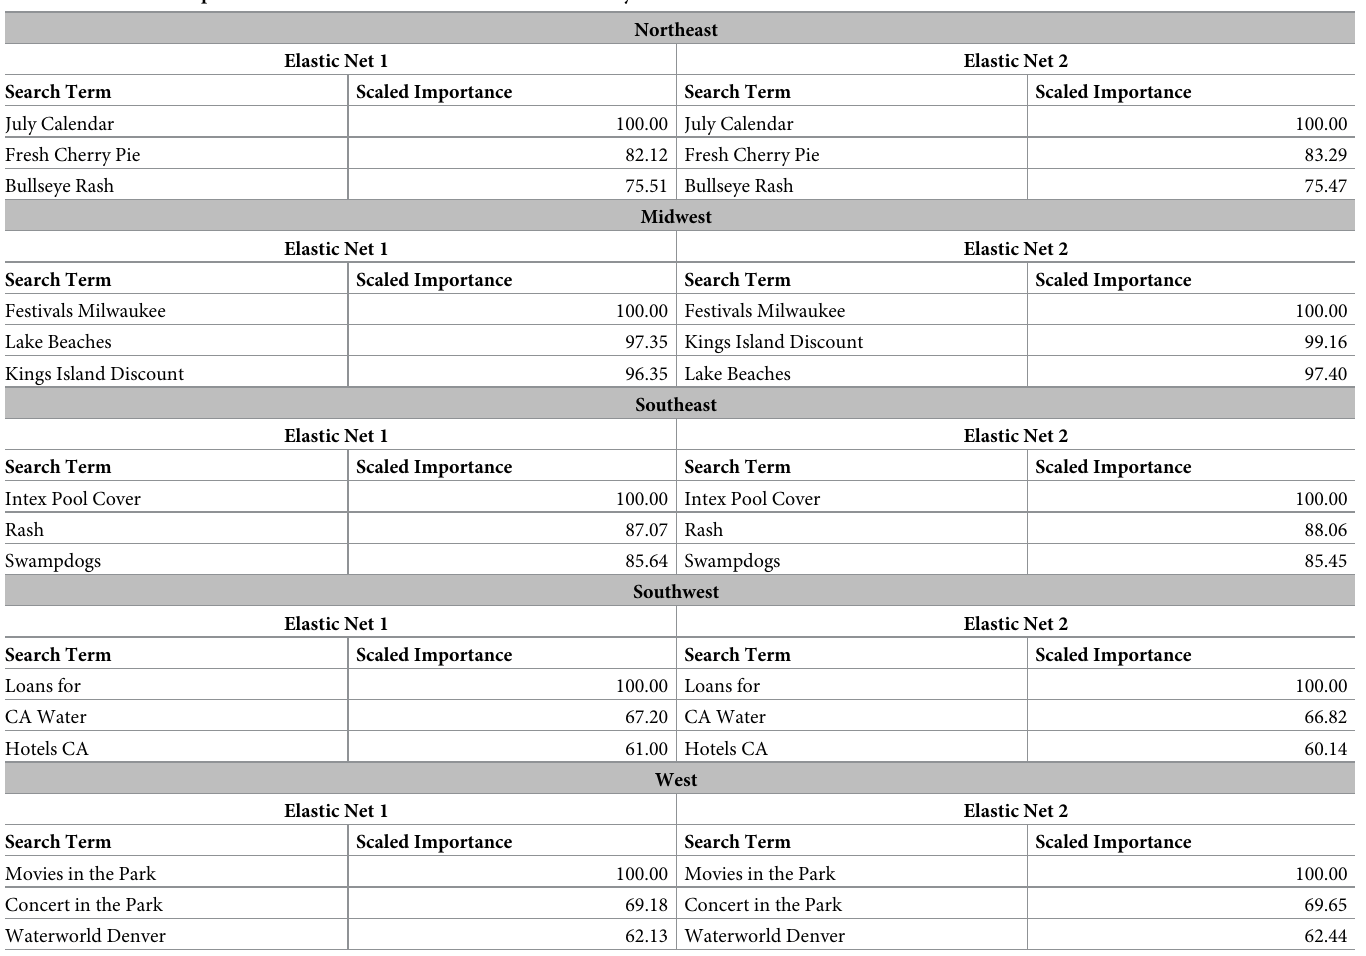
Table 7. Three most important terms for each model often environmentally